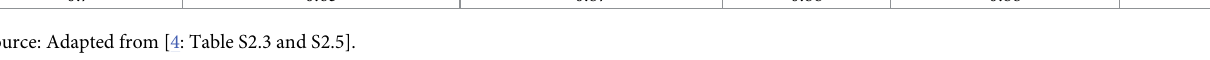
Table 4. Assumed Australian (NSW, VIC, and WA) vaccine effectiveness.